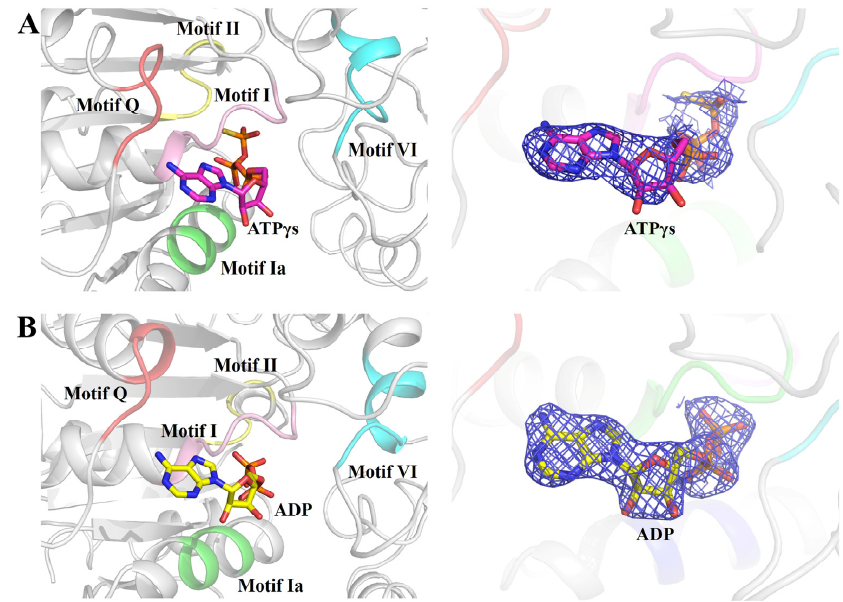
Figure 2. ATP γ S or ADP molecule binding in the helicase center (RD1 and RD2) of RadD. ( A ) Enlarged view of five conserved motifs interacting with ATP γ S. The motif Q is shown in tv-red, motif I in pink, motif Ia in green, motif II in yellow, and motif VI in cyan. ATP γ S is shown as sticks, and the 2Fo-Fc electron density contoured at 1.0 σ . ( B ) Enlarged view of five conserved motifs interacting with ADP. ADP is shown as sticks, and the 2Fo-Fc electron density is contoured at 1.0 σ